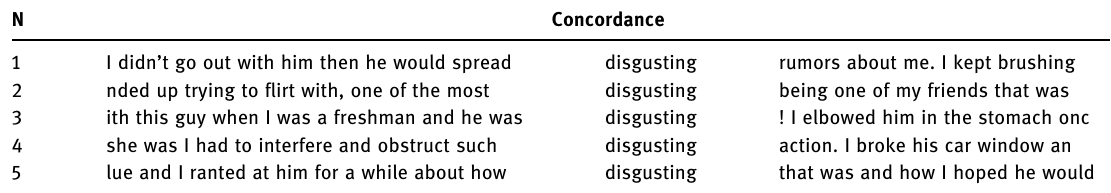
Table 17: Concordance lines for disgusting N